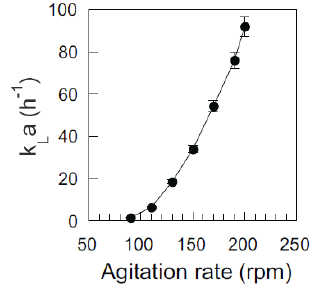
Figure 2. Determination of k a in 250-mL HT tubes. The HT tubes were filled with L 100-mL deionized water, and measurements were made at 37 °C using a dynamic method ( n = 4, error bars represent SD).